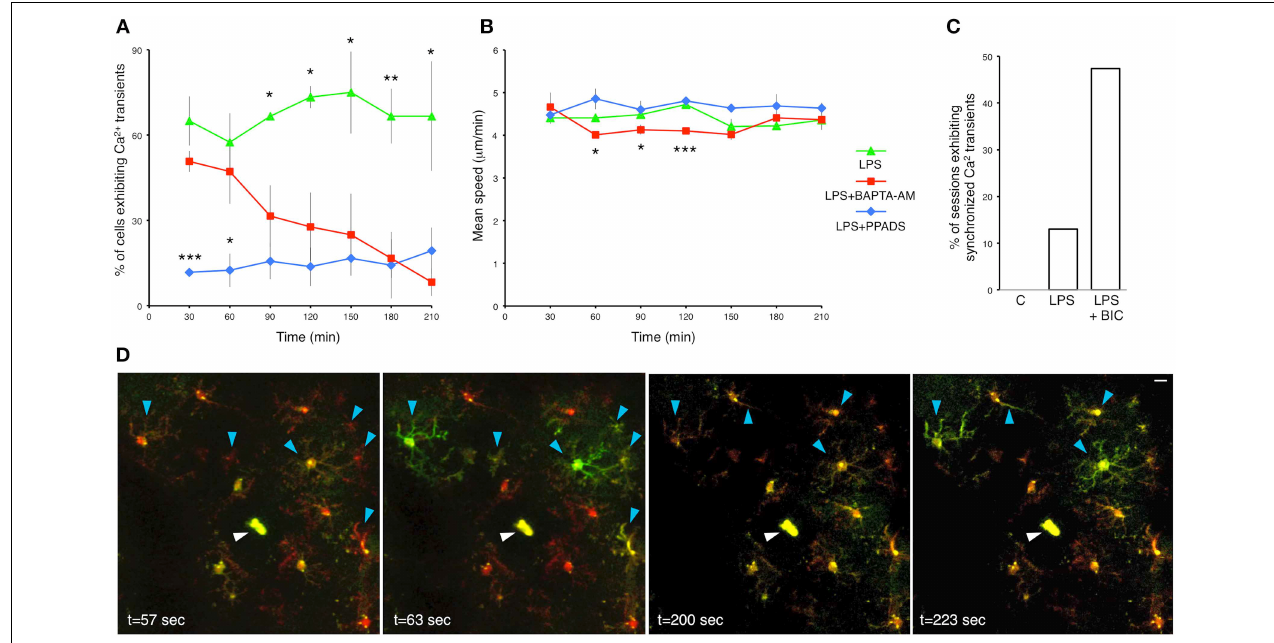
FIGURE 4 | Pharmacological interrogation of calcium responses in LPS-primed microglia. (A) Percentage of LPS-primed microglia exhibiting Ca 2 + transients in response to focal laser injury as a function of time. BAPTA-AM (5 µ g/ml) and PPADS (5mM) were topically applied through the craniotomy 12h after subcutaneous LPS administration. Two focal laser injuries were induced half an hour later, and were immediately followed by a 20min long imaging session. Successive injury/imaging sessions were taken in 30min intervals. Upper asterisks refer to statistical significance between LPS and LPS+BAPTA-AM treatments. Lower asterisks refer to statistical significance between LPS+BAPTA-AM and LPS+PPADS treatments. (B) Average speed of microglial processes as a function of time after BAPTA-AM and PPADS application. (C) A bar graph illustrating the fraction of imaging